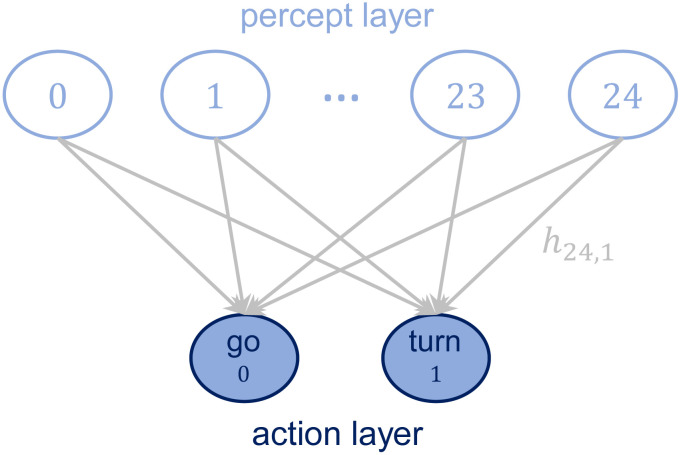
Structure of the ECM.The ECM consists of two layers, one for the percepts and one for the actions. Percepts and actions are connected by edges whose weight hij determines the transition probability from the given percept to each action (see Sec. 2.2 for details on the model).